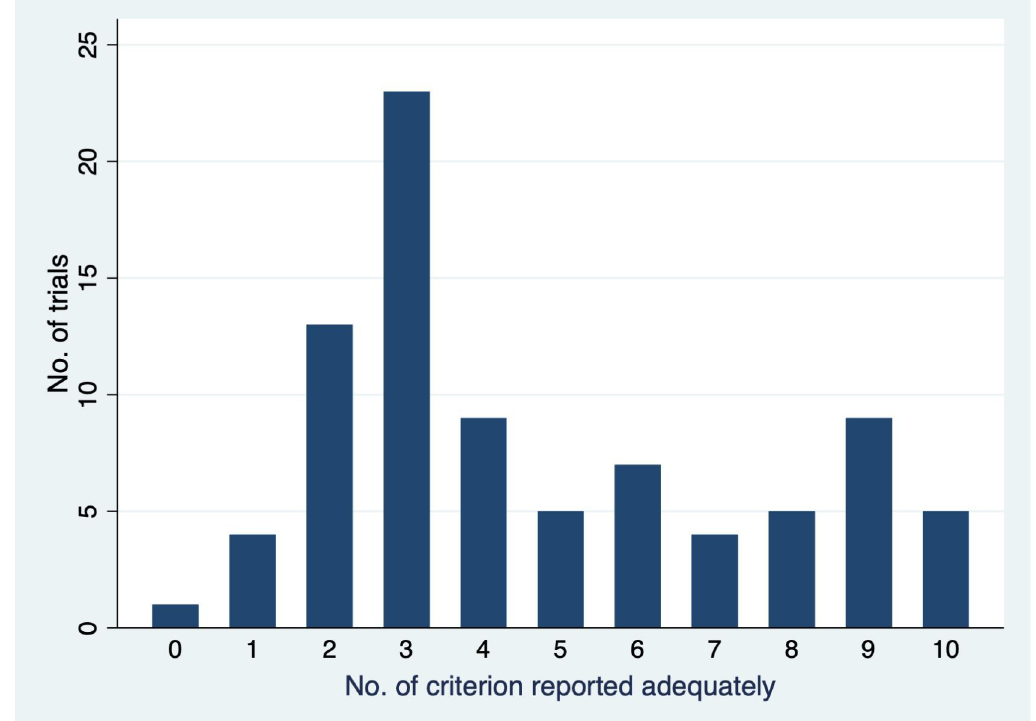
Fig 2. Total number of criterion which were reported adequately in all